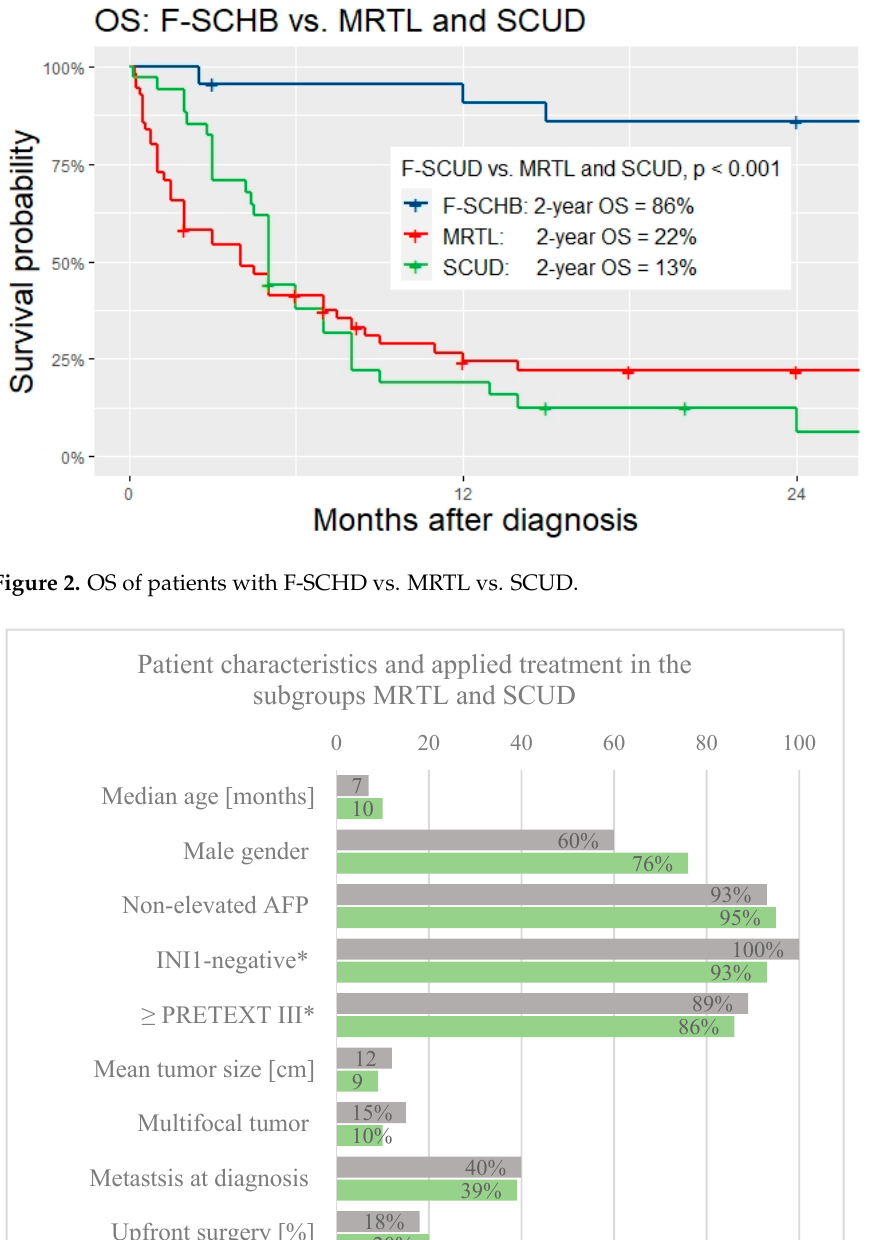
Figure 2. OS of patients with F-SCHD vs. MRTL vs. SCUD. Table 2. F-SCHB vs. MRTL/SCUD.